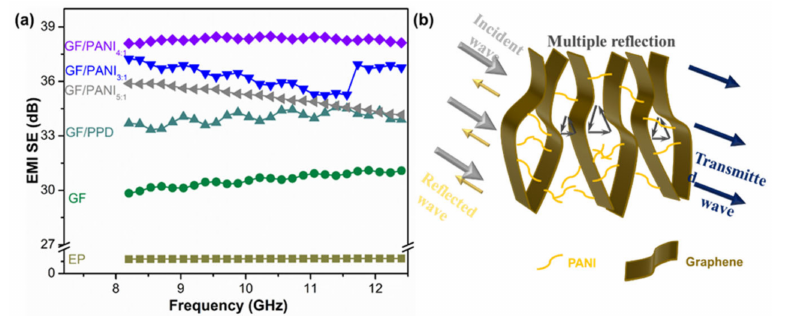
Figure 8. ( a ) EMI SE values of the f the EP, GF@EP, GF/PPD@EP GF/PANI 5:1 @EP, GF/PANI 4:1 @EP, GF/PANI 3:1 @EP nanocomposites and ( b ) schematic illustration of EMI shielding mechanism.